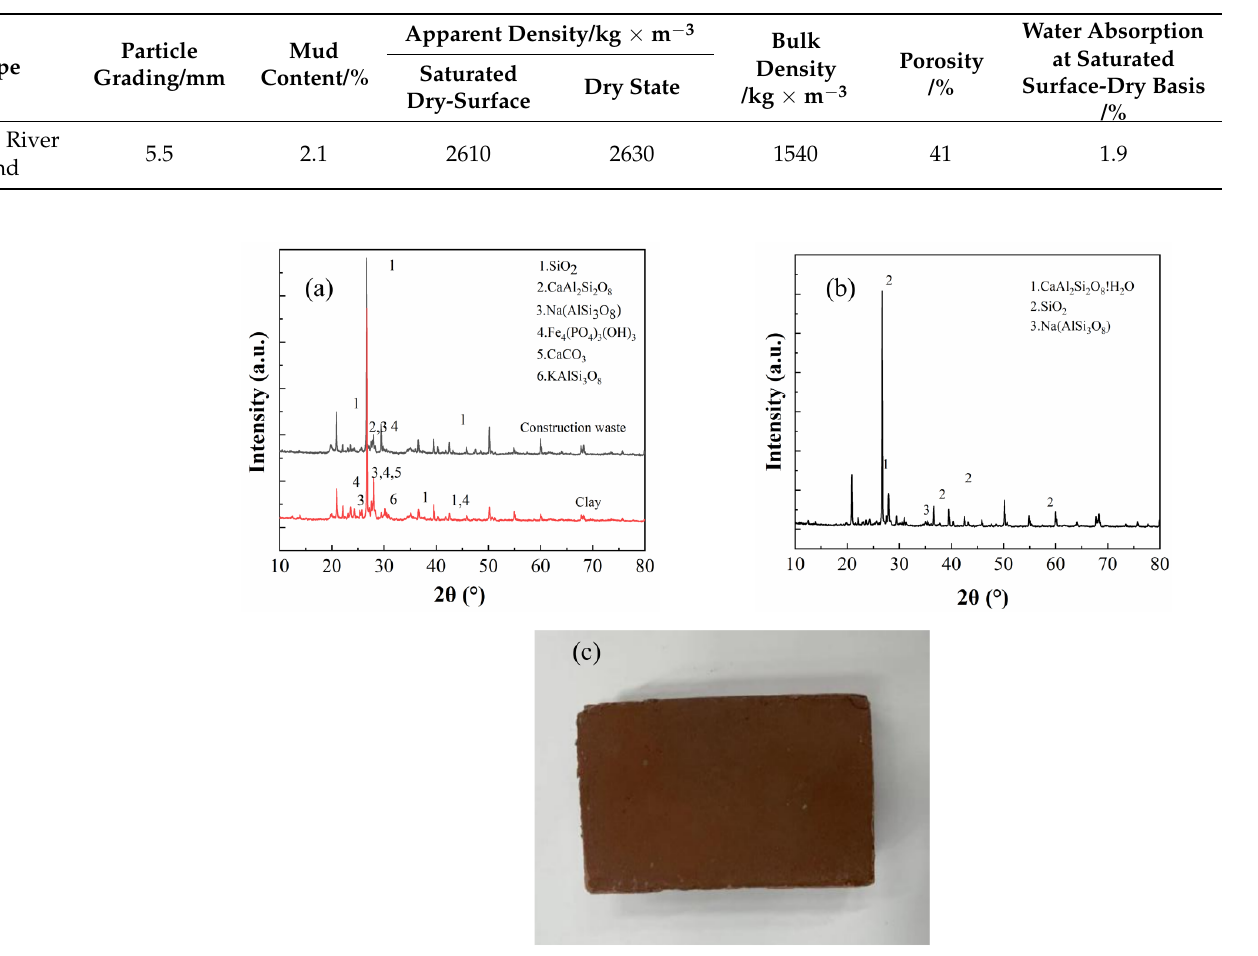
Table 4. Physical properties of Yellow River sand.